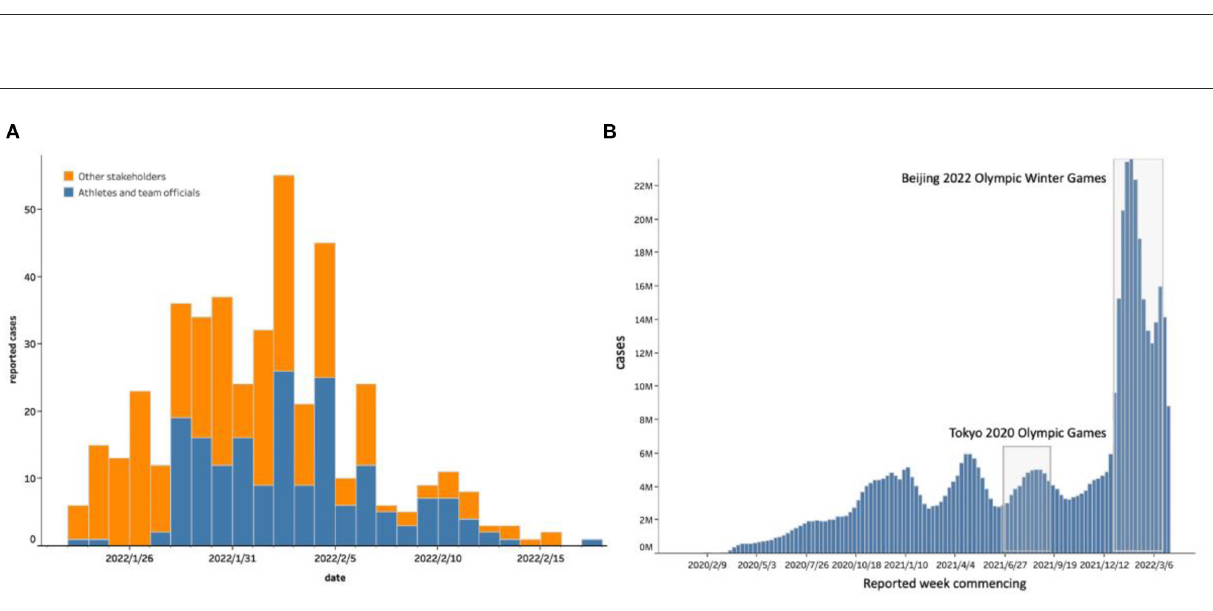
FIGURE2 The number of confirmed positive cases by stakeholder types during the Beijing 2022 Olympic Winter Games. (A) Depicts the epidemiological curve of coronavirus disease 2019 (COVID-19) cases during the Beijing 2022 Olympic Winter Games, broken down by stakeholder types. (B) Shows the context when the Beijing 2022 Olympic Winter Games were held, namely during the highest peak of COVID-19